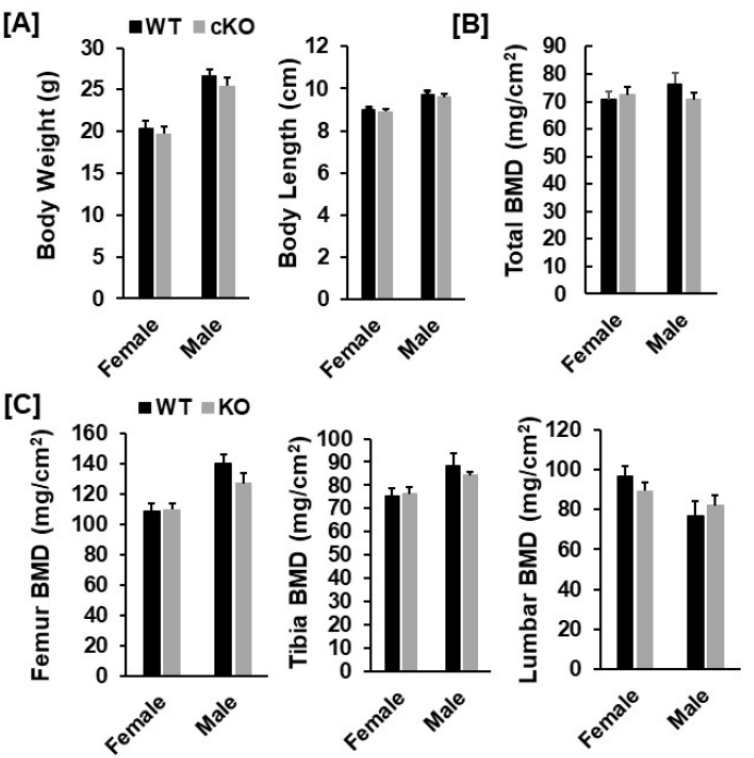
Figure 2. DXA analyses revealed no significant changes in bone parameters in the Phd3 cKO mice at 16 weeks of age. ( A ): Body weight and body length of the WT and cKO mice, respectively. ( B , C ): Total body, femur, tibia, and lumbar BMD of the WT and the cKO mice, respectively, measured by